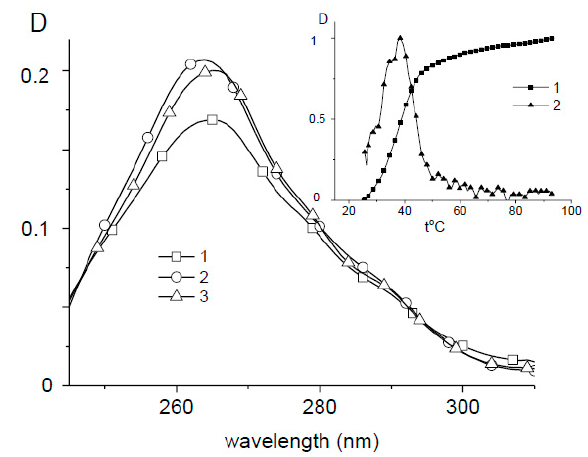
Figure 5. Absorption spectra of Ag–Phen solution without DNA at 25 °C (1), 95 °C (2) and after cooling of solution 2 to 25 °C (3). Insert: The melting curve and its 1st derivative for Ag–Phen in 0.005 M, C (Ag–Phen) = 6 × 10 − 6 M.